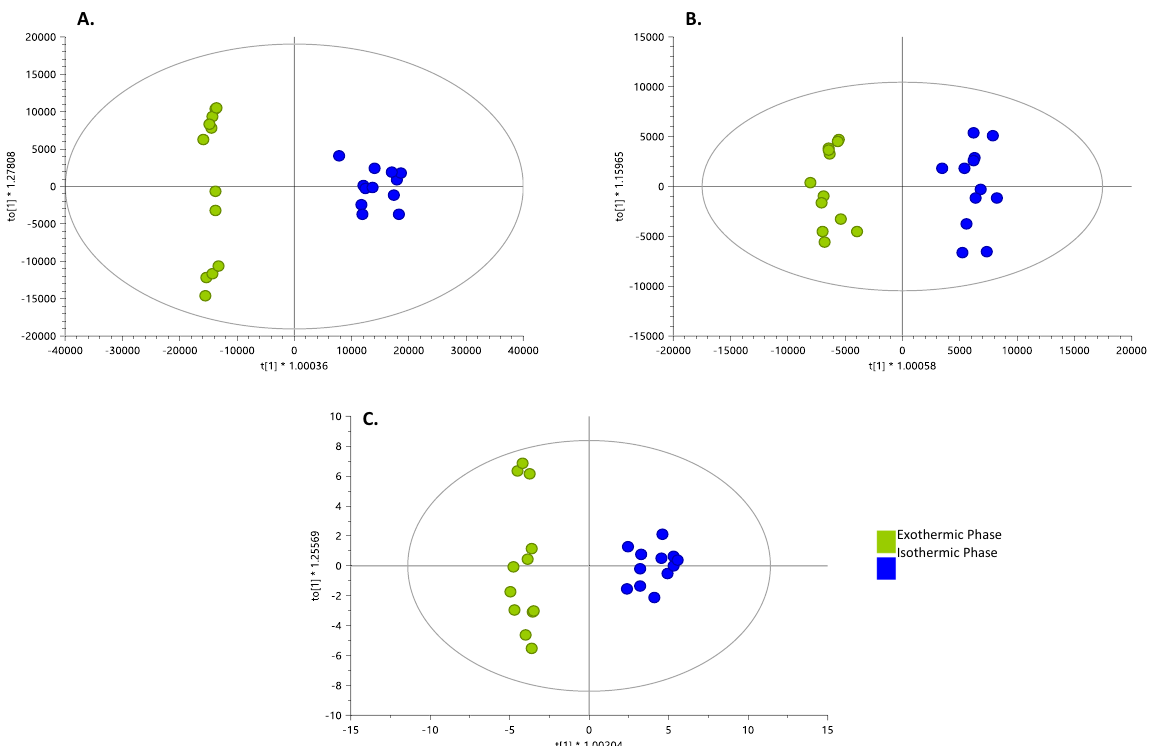
Figure 6. OPLS-DA models for two phases. ( A ) MF by LC–MS( +): R 2 (cum) : 0.804, Q 2 (cum) : 0.962, cv-anova: 3.58e−13; ( B ) MF by LC–MS(-): R 2 (cum) : 0.739, Q 2 (cum) : 0.96, cv-anova: 5.67e−07; ( C ) MF by GC–MS: R 2 (cum) : 0.702, Q 2 (cum) : 0.864, cv-anova: